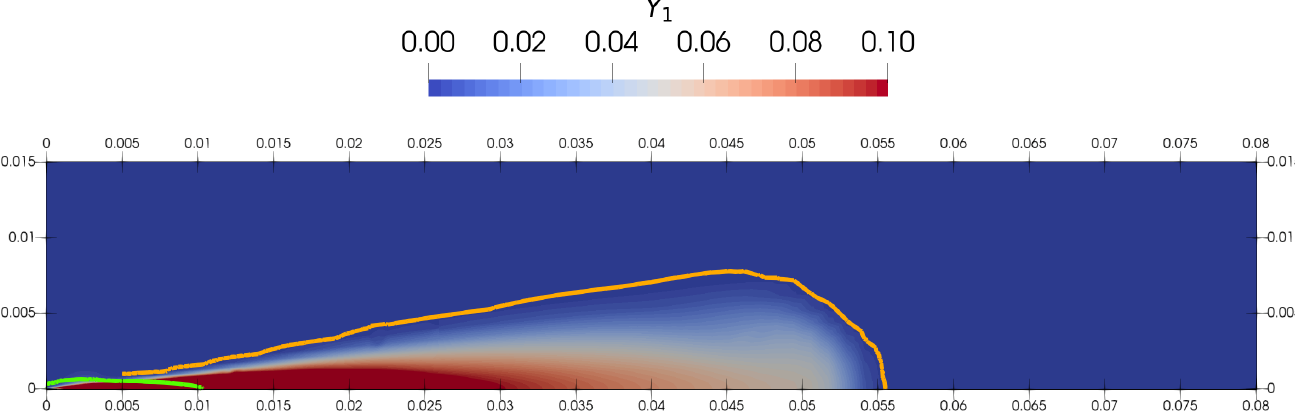
Figure 8. Vapor penetration at t = 1.4 ms. The green line gives the iso-contour α d = 0.1%, and the orange line denotes Y 1 = 0.1%. The comparison of mixture fraction profiles at two different radial positions is given by Figures 9 and 10. Figure 9 gives the comparison at the streamwise location z = 25 mm in the radial direction. The “Gaussian” mixture fraction profile was predicted well, especially the peak value, but there was a slight underprediction for the outer part of the